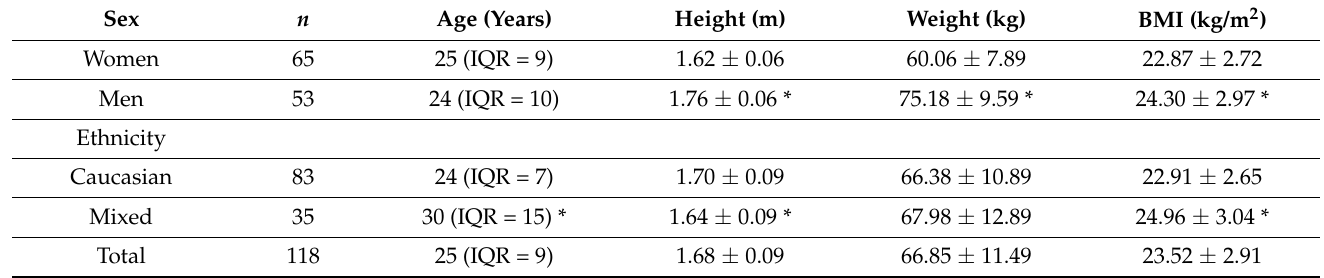
Table 2. Demographic characteristics of the study population according to sex and